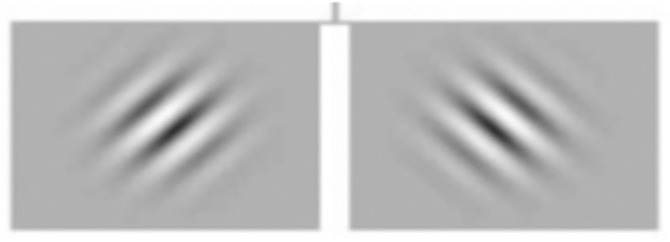
Example of the sinusoidal stimuli used in the experiments.The grating stimuli were circular Gabor patches of 2 degree standard deviation with sinusoidal luminance profile. The peak spatial frequencies tested were 0.5, 1.5 and 3 cycles/degree